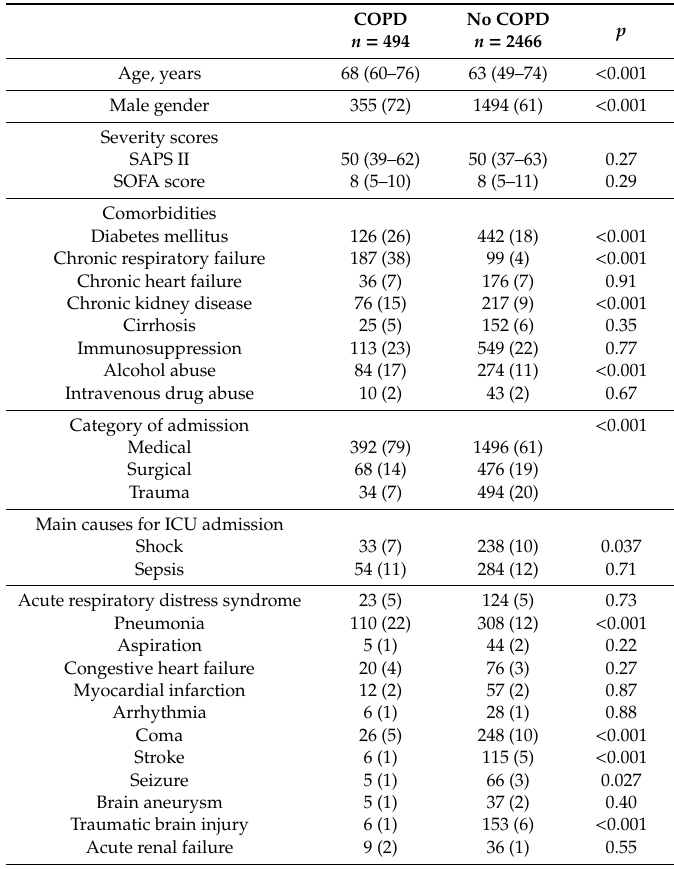
Table 1. Patient characteristics at intensive care unit (ICU) admission in chronic obstructive pulmonary disease (COPD) and non-COPD